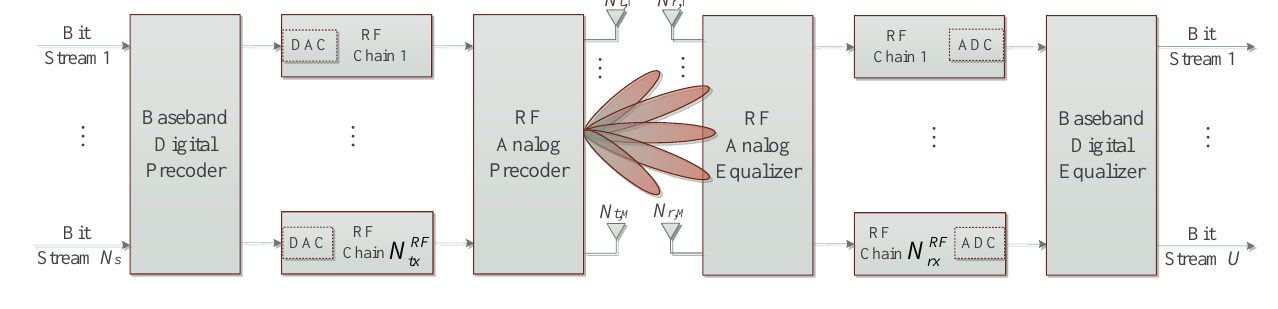
Figure 3. Multi-User Hybrid Analog–Digital Beamforming Architecture. Table 3. A literature comparison for CF mMIMO systems under the mmWave frequency